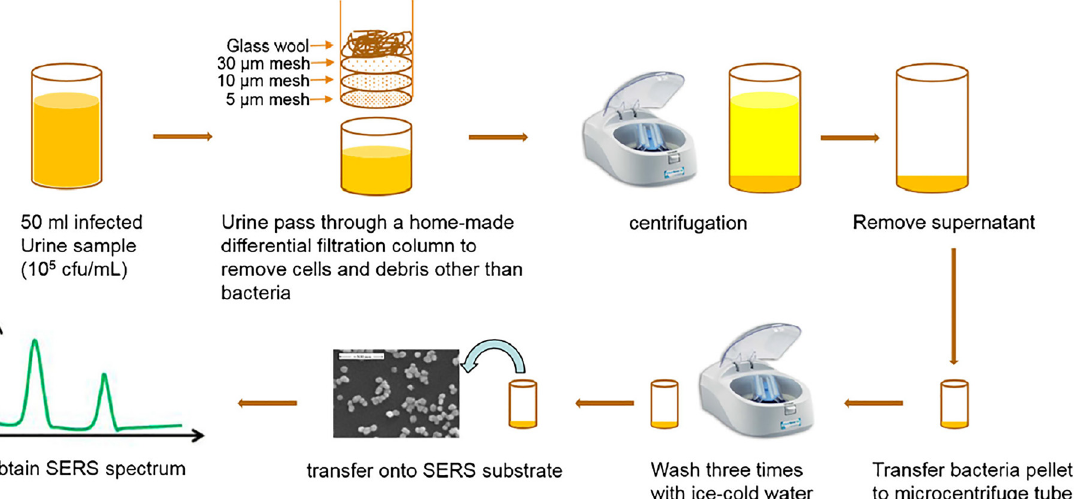
Figure 8: The relative contribution of each of thesevenpurinesfoundto contributeto the bacterial surface enhanced Raman scattering (SERS) spectra is summarized in this bar graph. Strain-specific differences are evident, it can be seen how the pattern of contributing purines is more different between the four species than between the strains of a given species. Reprinted with permission from Premasiri et al. [62]: Springer Nature, Copyright (2017).